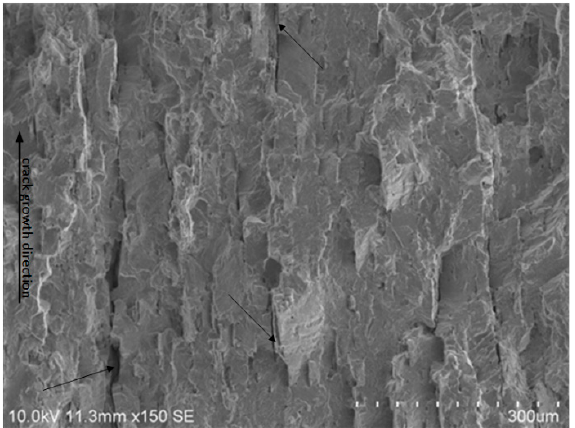
Figure 13. Representative fatigue fracture surface of the broken specimen tested under mode I condition (R = 0.5)—approximately 6 mm from notch. Metals 2019 , 9 , x FOR PEER REVIEW